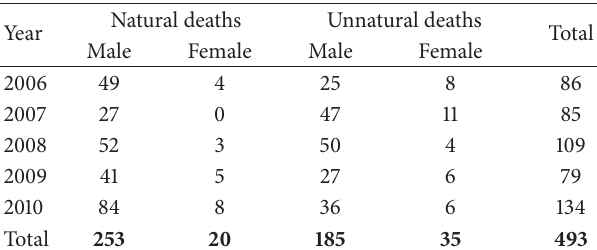
Table 1: Year- and sex-wise distribution of natural and unnatural deaths in 50+ population.